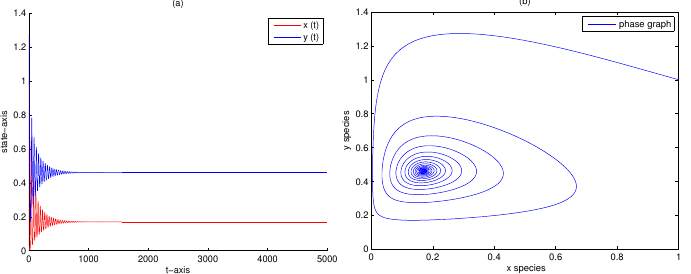
Figure 6. Global stability of E ∗ ( x ∗ , y ∗ ) of Model (2) with f = 5: ( a ) time-series curves of x ( t ) and y ( t ) and ( b ) phase diagram.